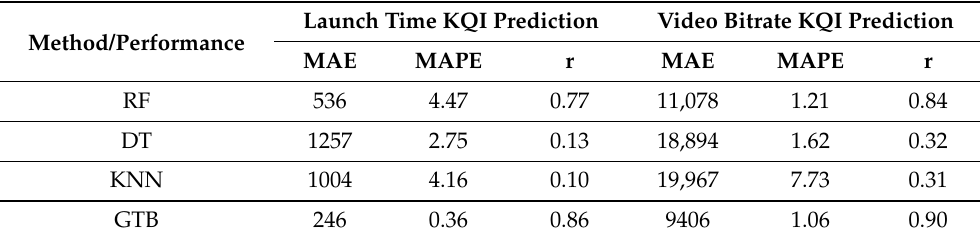
Table 13. Bitrate and launch time prediction performance results using 80% for training and 20% for testing with 5-fold for cross validation.